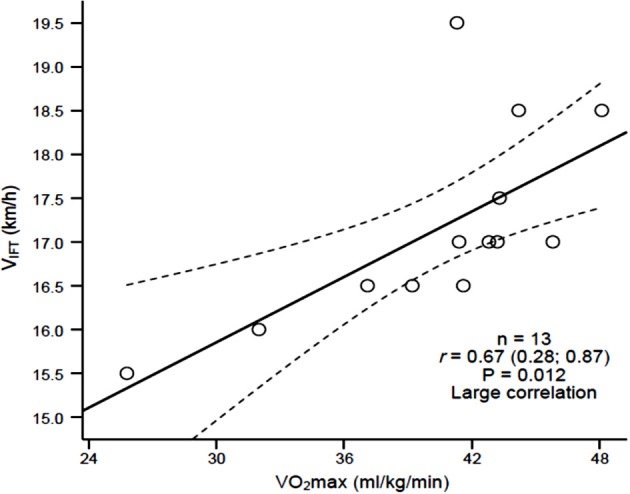
Relationship between 30–15IFT end speed (VIFT) and measured maximal oxygen consumption (VO2max) obtained from the incremental continuous running treadmill test.